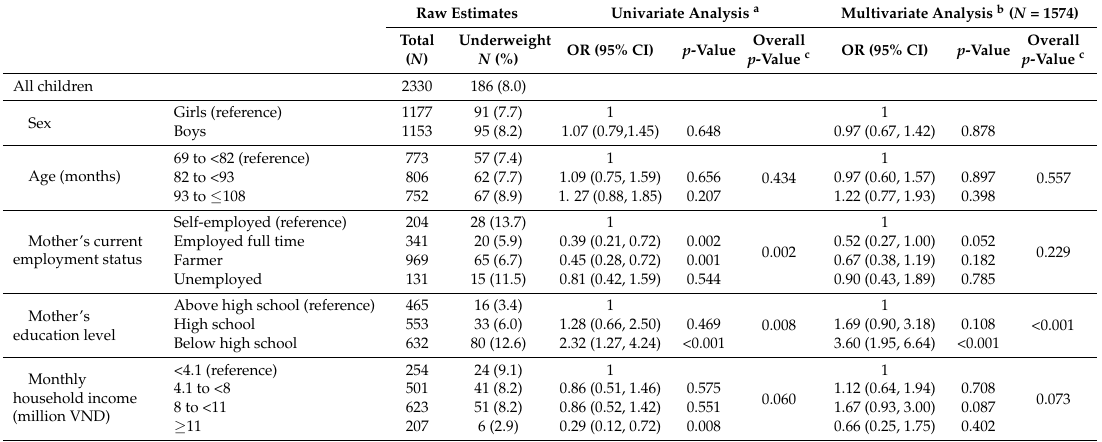
Table 2. Prevalence of underweight (weight-for-age z -score < − 2) and associated sociodemographic factors in 6–9-year-old children in rural areas of